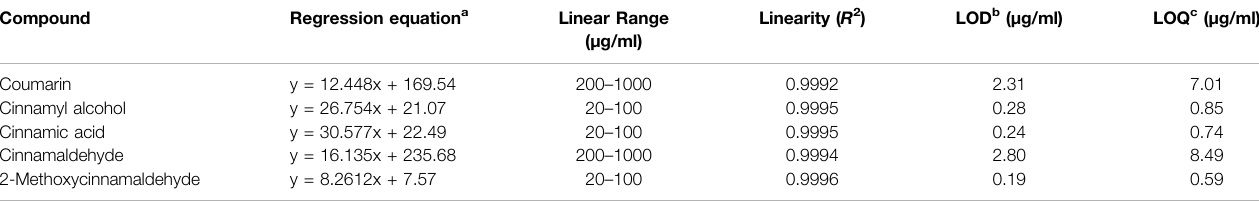
TABLE 1 | Regression equation, linearity, LOD, and LOQ for fi ve marker compounds ( n = 3). Compound